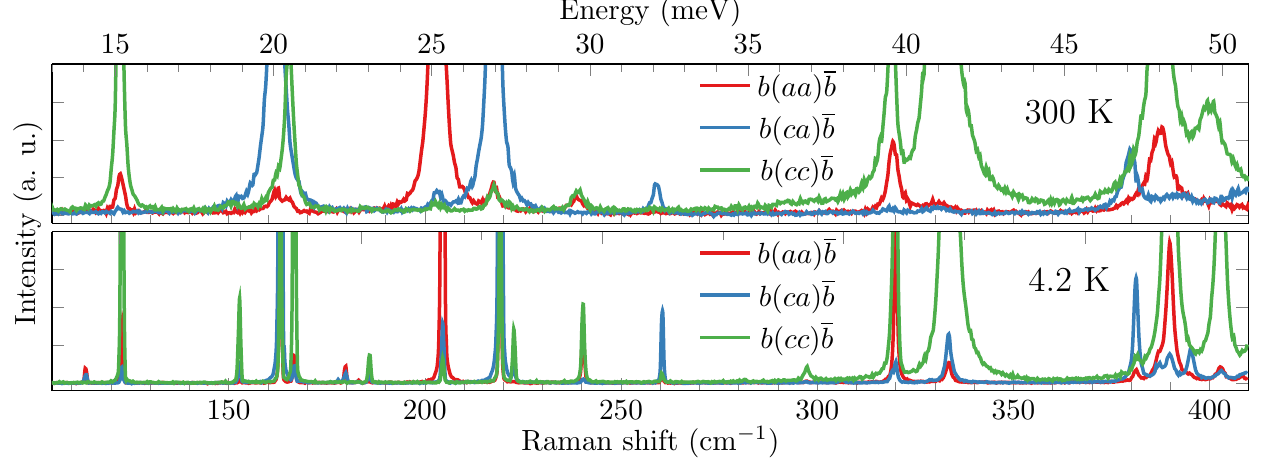
Figure 2. The selection of Fe 3 BO 6 Raman scattering spectra measured at 300 and 4.2 K for distinct polarization configurations within ac -plane.